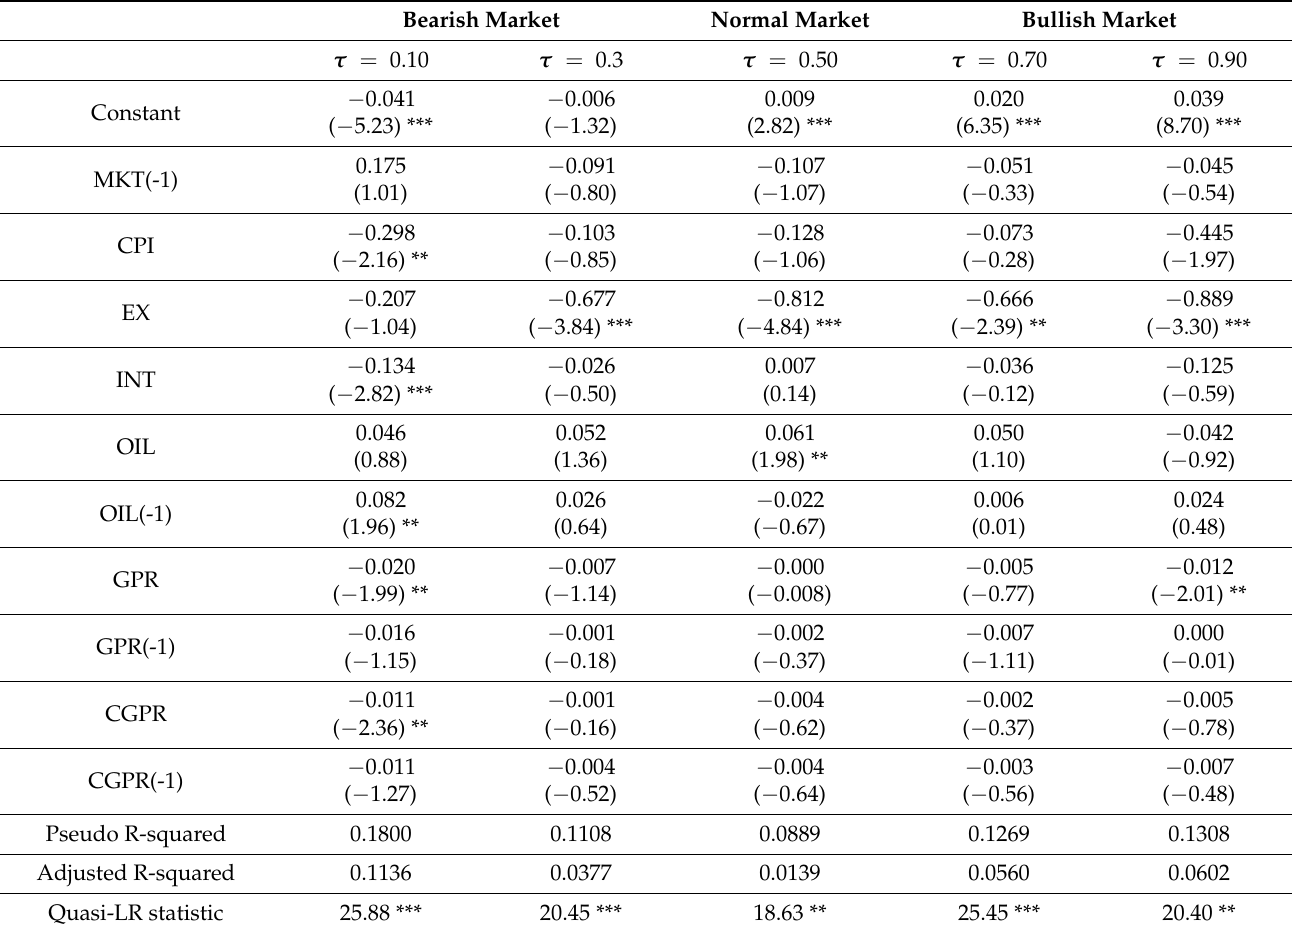
Table 5. Results of Quantile Regression for Conventional Stock. Bearish Market Normal Market